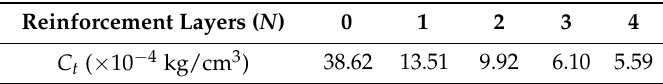
Table 4. Relationship between C t and